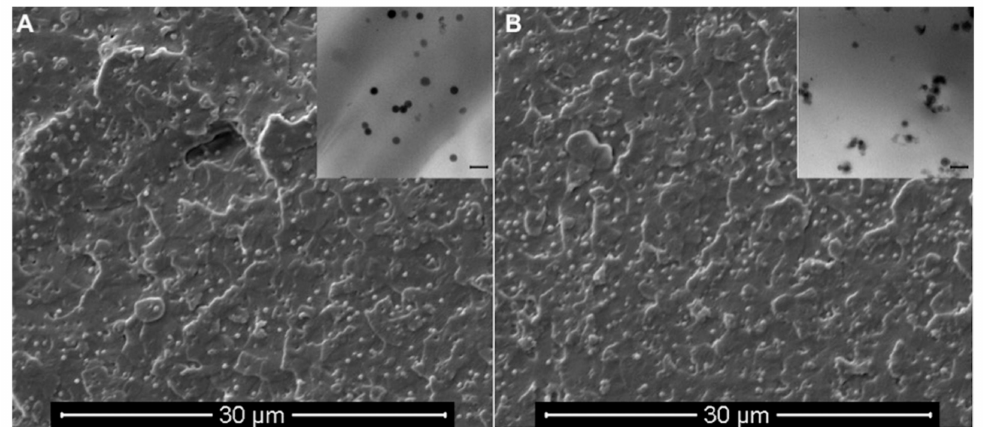
Figure 4. SEM images of PLA / SiO 2_ s ( A ) and PLA / SiO 2_ w ( B ) nanocomposites; the inserts are the corresponding TEM images of the samples at low magnification (scale bar 400 nm).